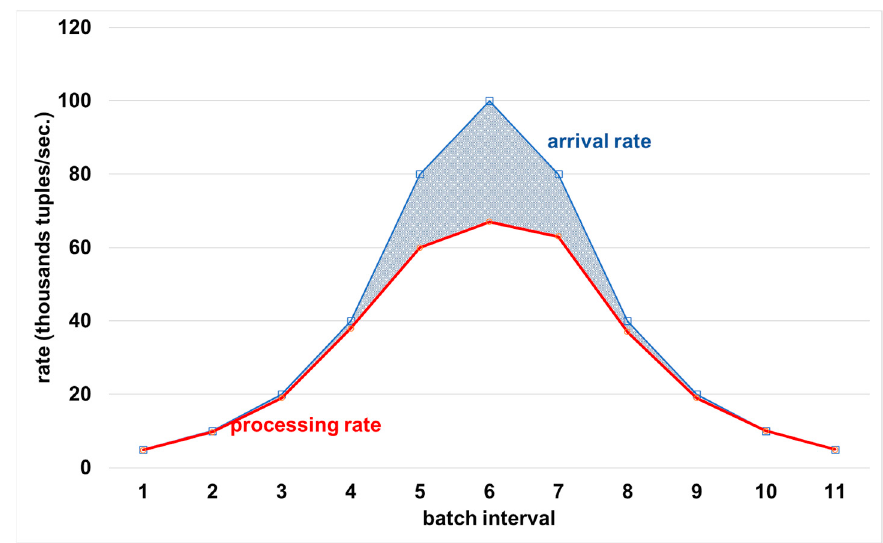
Figure 4. ApproxSSPS ability to catch-up with various oscillations in data stream arrival rates. The patterned area between the two lines shows the dropped tuples. When the area is minimal, it means a higher sampling fraction, which allows more data to continue its way to the approximation operator downstream the system. This leads to a higher accuracy as opposed to those that result in the same load arriving to the baseline system, as shown in Figure 5.